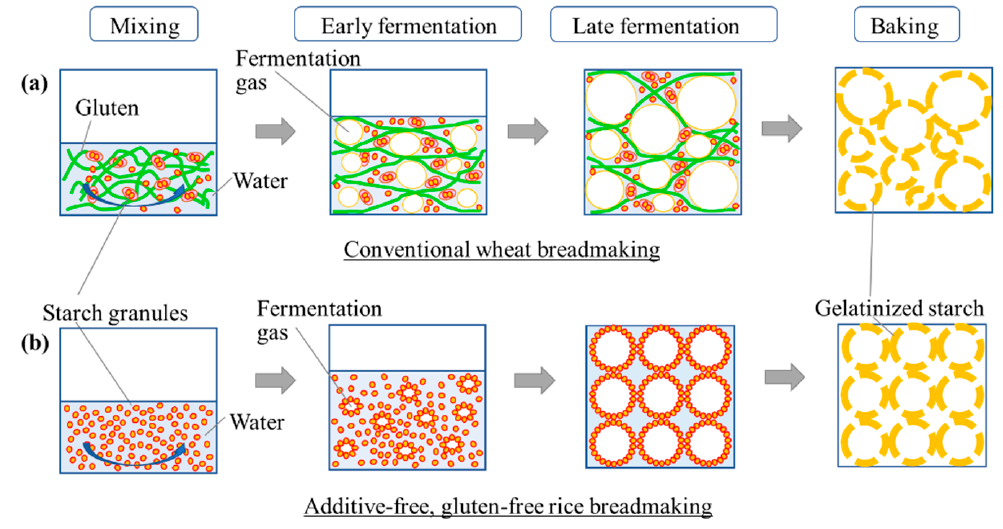
Figure 3. Comparison of breadmaking processes between wheat ( a ) and additive-free, gluten-free rice bread ( b ).